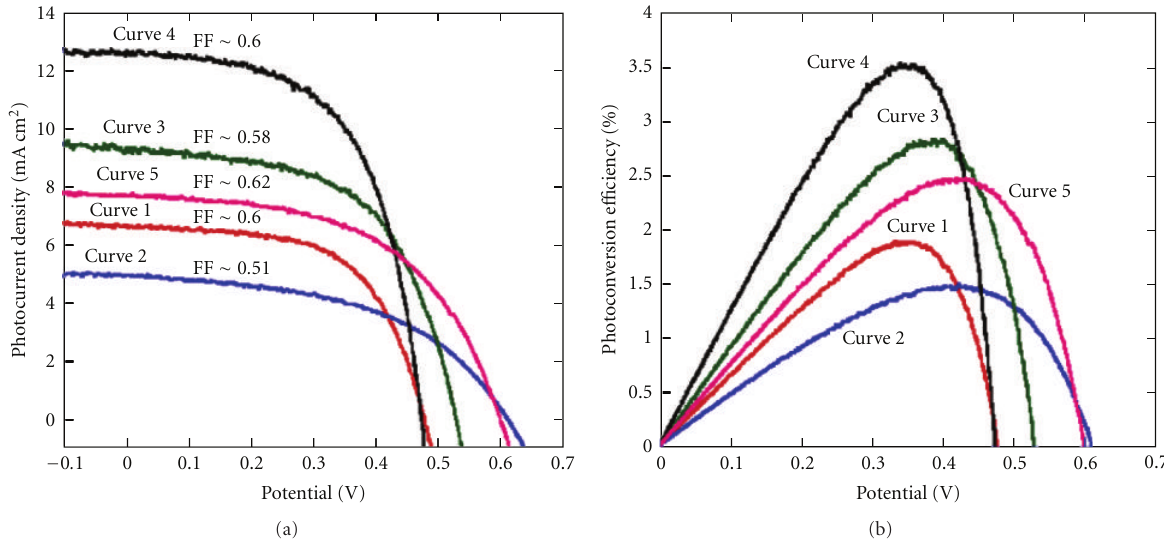
Figure 6: (a) Current-voltage characteristics and (b) the overall conversion e ffi ciency of solid-state photovoltaic devices made using P3HT/PCBM-coated TiO 2 nanotubes. Five curves, 1 to 5, represent five di ff erent TiO 2 surface treatments before polymer blend spin coating. Treatment of nanotubes for (1) Curve 1—TBP, (2) Curve 2—CB, (3) Curve 3—o-DCB, (4) Curve 4—soaked in o-DCB, and (5) Curve 5—soaked in o-DCB and baked at 165 ◦ C. Curves 1 to 4 were baked at 150 ◦ C. Reprinted with permission from